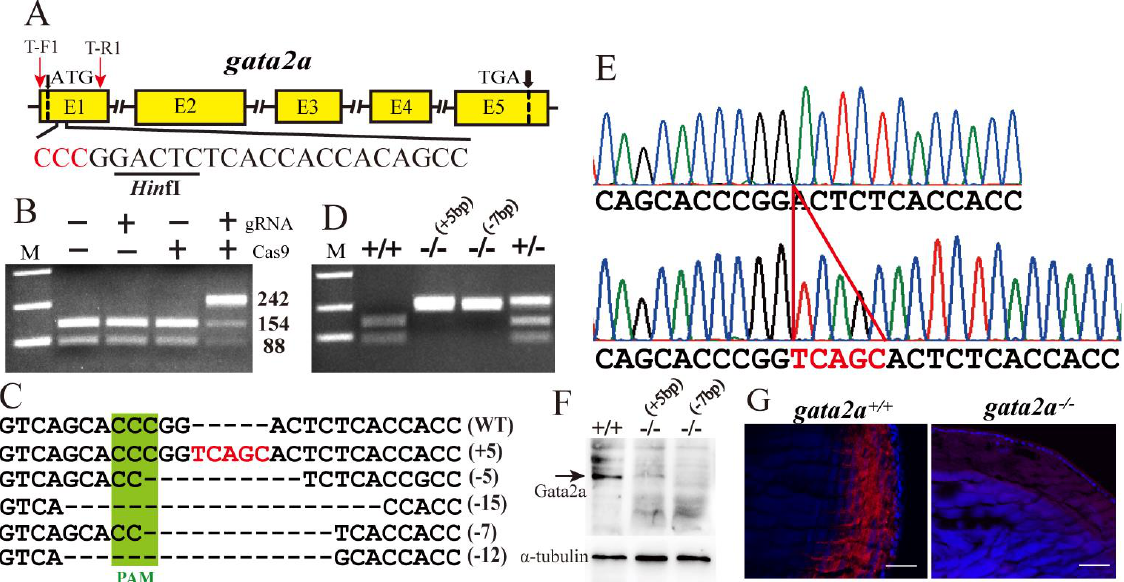
Figure 2. Generation of tilapia gata2a mutant line by CRISPR/Cas9. ( A ) Schematic diagram showing gata2a gene structure and sgRNA target site near the translation start site on the antisense strand. ( B , C ) Generation of the gata2a mutant line. Mutations at the gata2a locus were analyzed by restriction enzyme digestion ( B ) and DNA sequencing ( C ). Deletions are indicated by dashes ( C ). The numbers in brackets represent the bases deleted/inserted from each allele. ( D ) Identification of F2 genotypes by restriction enzyme digestion assay. Homozygous mutants with different mutation types (+5 bp and − 7 bp) were obtained. ( E ) Sequencing results of the gata2a gene from WT and homozygous mutant fish. ( F ) Western blot was carried out to show the specificity of the antibody against Gata2a. ( G ) Immunofluorescence was used to test the specificity of the Gata2a antibody. Scale bar: 50 μm . M, marker; PAM, protospacer adjacent motif.